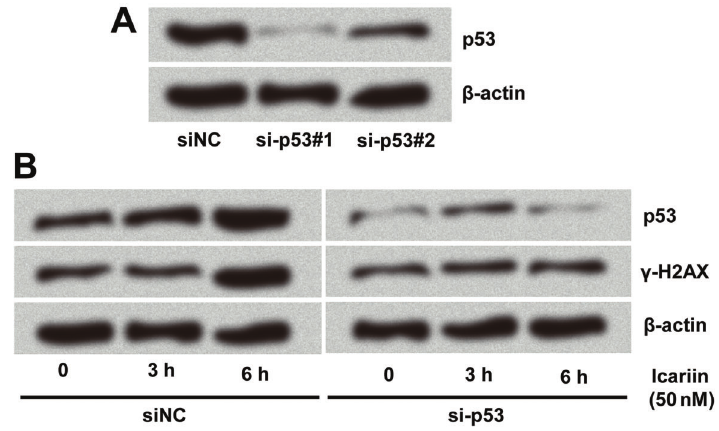
Figure 6. Icariin induced DNA damage in HCT116 cells. A , The protein levels of p53 were analyzed after transfection with two different sequences of p53 targeted siRNAs (si-p53 #1 and si-p53 #2). B , Effect of p53 knockdown on the induction of DNA damage by icariin. Data were obtained through western blot. b -actin was used as internal